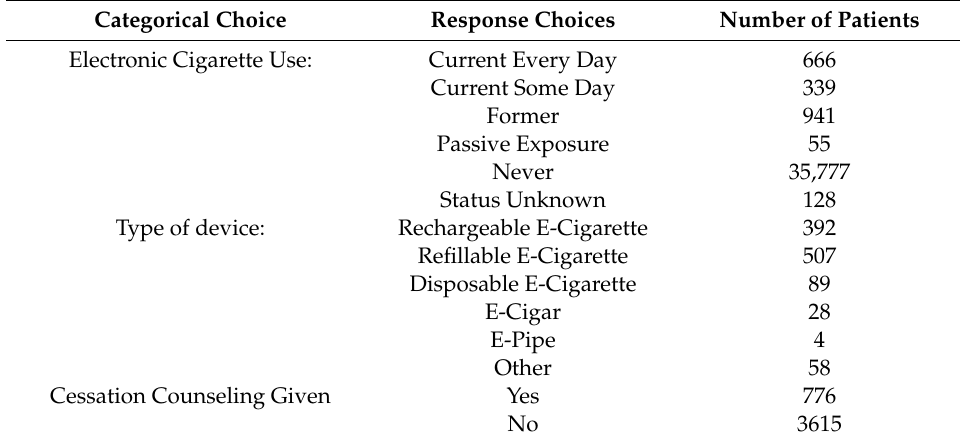
Table 1. E-cigarette information recorded by clinicians between October 7, 2019, to April 30, 2020. The number represents cumulative data during the time period.